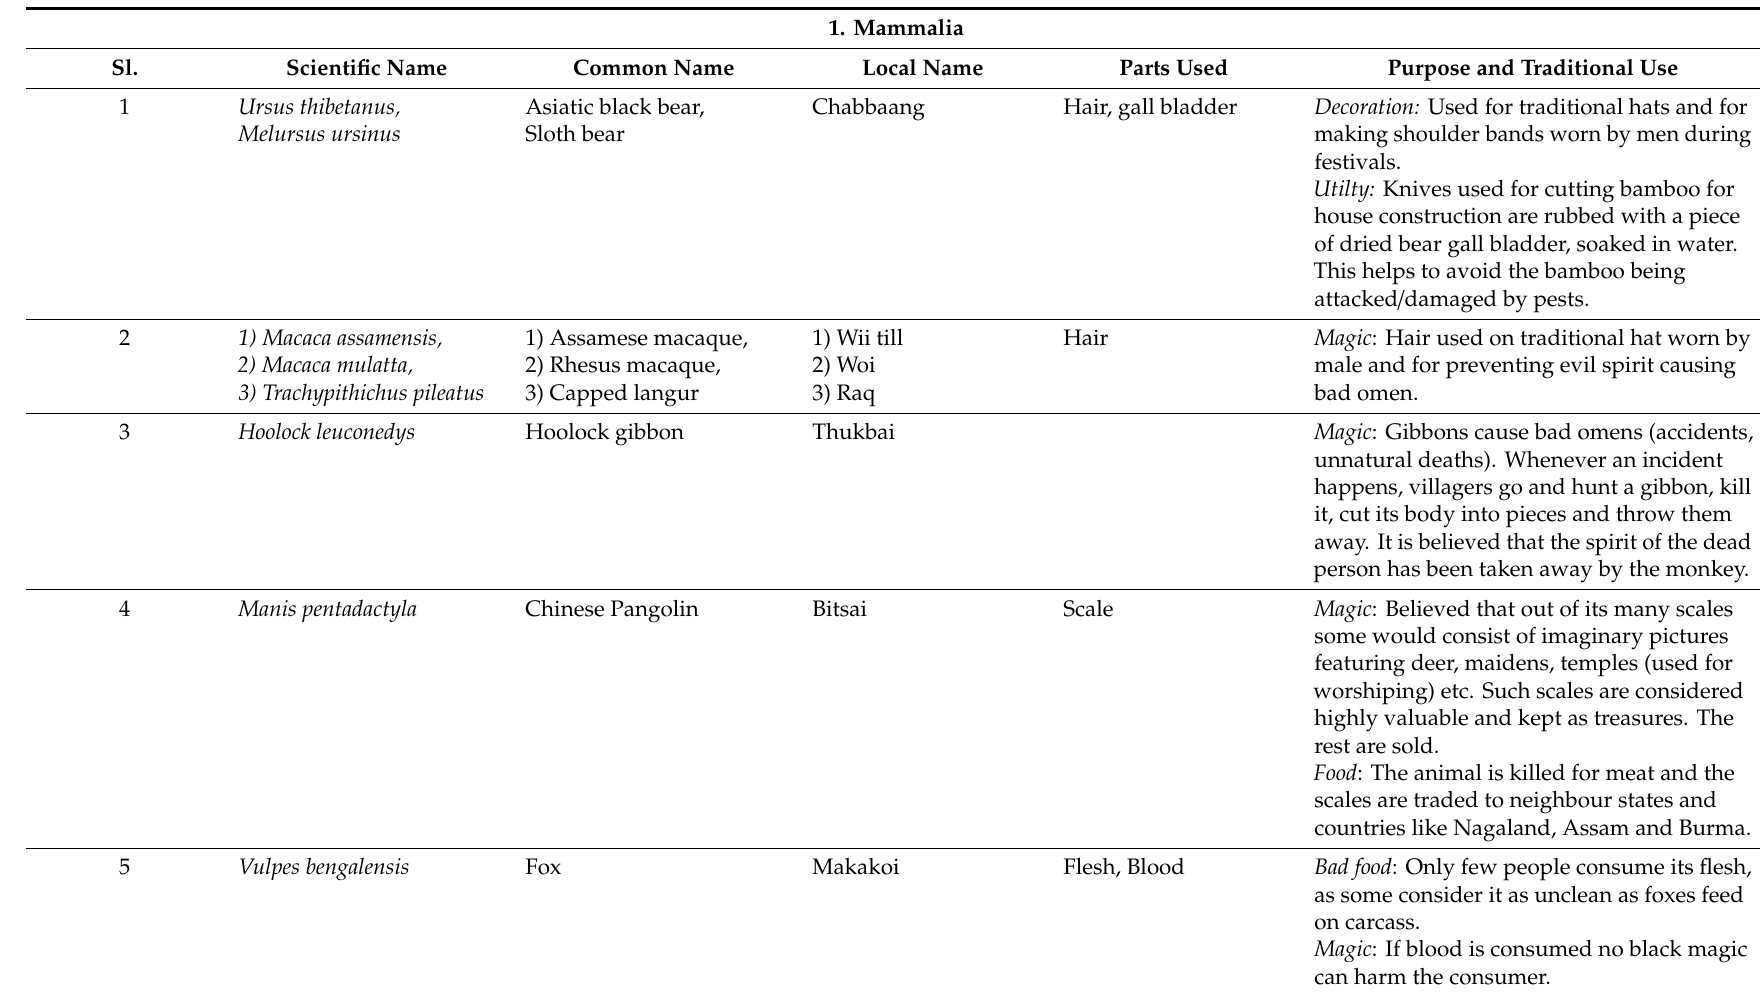
Table 1. Traditional knowledge associated with the Tangsa tribe. 1.